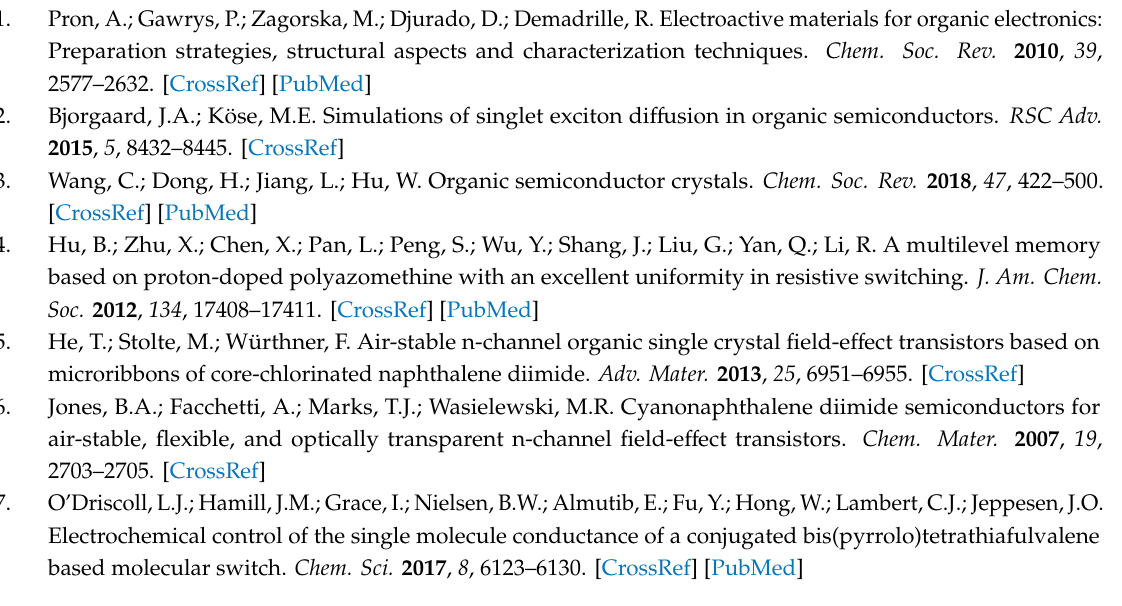
on a 300M Hz spectrometer at 303 K. Figure S11: 1 H NMR for 6 in DMSO-d 6 recorded on a 500M Hz spectrometer at 303 K. Figure S12: 13 C NMR for 6 in DMSO-d 6 / TFA-d solvents recorded on a 500M Hz spectrometer at 303 K. Figure S13: APCI for 1 . Figure S14: APCI for 2 . Figure S15: APCI for 3 . Figure S16: APCI for 4 . Figure S17: ESI for 5 . Figure S18: ESI for 6 . Figure S19: FT-IR spectra of 1 , 2 , and 3 (KBr pellets). Figure S20: FT-IR spectra of 4 , 5 , and 6 (KBr pellets). Figure S21: TGA curves for 1–6 . Figure S22: UV-vis spectra for 1–6 in DCM. Figure S23: UV-vis spectra for 1–6 in THF. Figure S24: UV-vis spectra for 1–6 in EtOH. Figure S25: UV-vis spectra for 1–6 in CH 3 CN. Figure S26: Normalized emission spectra of 2 were excited at 290 nm in CH 3 CN (black), EtOH (red), THF (blue), and DCM (greenish blue), respectively at room temperature in air. Figure S27: Normalized emission spectra of 3 were excited at 286 nm in CH 3 CN (black), EtOH (red), THF (blue), and DCM (greenish blue), respectively at room temperature in air. Figure S28: Normalized emission spectra of 4 were excited at 284 nm in CH 3 CN (black), EtOH (red), THF (blue), and DCM (greenish blue), respectively at room temperature in air. Figure S29: Normalized emission spectra of 5 were excited at 290 nm in CH 3 CN (black), EtOH (red), THF (blue), and DCM (greenish blue), respectively at room temperature in air. Figure S30: Normalized emission spectra of 6 were excited at 290 nm in CH 3 CN (black), EtOH (red), THF (blue), and DCM (greenish blue), respectively at room temperature in air. Figure S31: Emission photographs for 1–6 in DCM (top), EtOH (middle), and CH 3 CN (bottom) excited at 254 nm (left) and 365 nm (right), respectively at room temperature in air. Figure S32: Solid state emission spectra excited at 250 nm for 1–6 at room temperature in air. Figure S33: Solid state emission spectra excited at 280 nm for 1–6 at room temperature in air. Figure S34: Emission photographs for 1–6 in solid state with regular light (top), excited at 365 nm (middle), and 254nm (bottom), respectively at room temperature in air. Figure S35: DPV in black dashed line and CV of 2 were measured in DMF with 0.1 M TBAPF 6 . CV of 2-Oxi in red solid line indicated oxidation run first and 2-Red in blue solid line indicated reduction run first. Pt wire, Pt disk, and Ag / AgCl were used for measurements with a scan rate of 0.1 Vs − 1 . Figure S36: DPV in black dashed line and CV of 3 were measured in DMF with 0.1 M TBAPF 6 . CV of 3-Oxi in red solid line indicated oxidation run first and 3-Red in blue solid line indicated reduction run first. Pt wire, Pt disk, and Ag / AgCl were used for measurements with a scan rate of 0.1 Vs − 1 . Figure S37: DPV in black dashed line and CV of 4 were measured in DMF with 0.1 M TBAPF 6 . CV of 4-Oxi in red solid line indicated oxidation run first and 4-Red in blue solid line indicated reduction run first. Pt wire, Pt disk, and Ag / AgCl were used for measurements with a scan rate of 0.1 Vs − 1 . Figure S38: DPV in black dashed line and CV of 5 were measured in DMF with 0.1 M TBAPF 6 . CV of 5-Oxi in red solid line indicated oxidation run first and 5-Red in blue solid line indicated reduction run first. Pt wire, Pt disk, and Ag / AgCl were used for measurements with a scan rate of 0.1 Vs − 1 . Figure S39: DPV in black dashed line and CV of 6 were measured in DMF with 0.1 M TBAPF 6 . CV of 6-Oxi in red solid line indicated oxidation run first and 6-Red in blue solid line indicated reduction run first. Pt wire, Pt disk, and Ag / AgCl were used for measurements with a scan rate of 0.1 Vs − 1